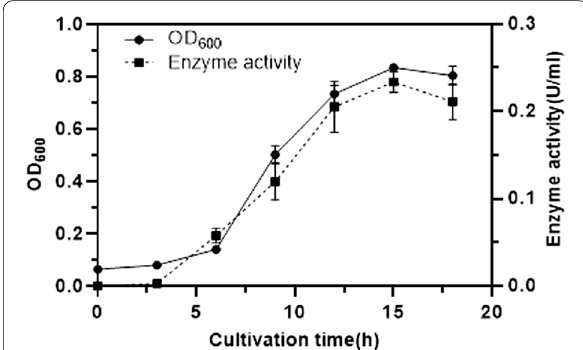
Fig. 3 Time course of Glutamicibacter sp. N1A3101cell growth and HOD activity in BSM medium containing acetate and histamine dihydrochloride as the carbon and nitrogen sources, respectively. The error bars represent standard error (n =